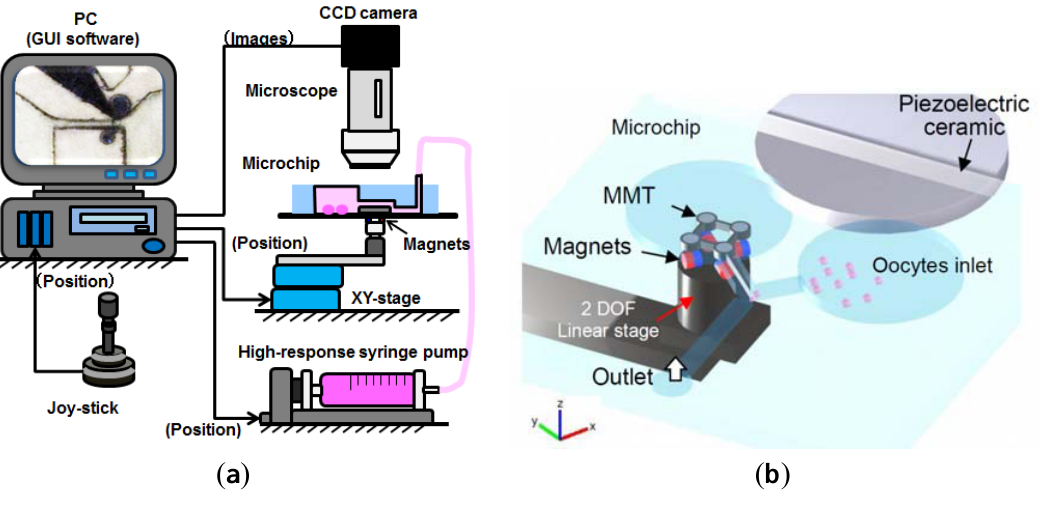
Figure 7. Components of experimental system: ( a ) experimental setup for the enucleation of oocytes including the linear stage for magnet actuation, a microfluidic chip, and a piezoceramic for generating vibrations on the microfluidic chip and ( b ) system